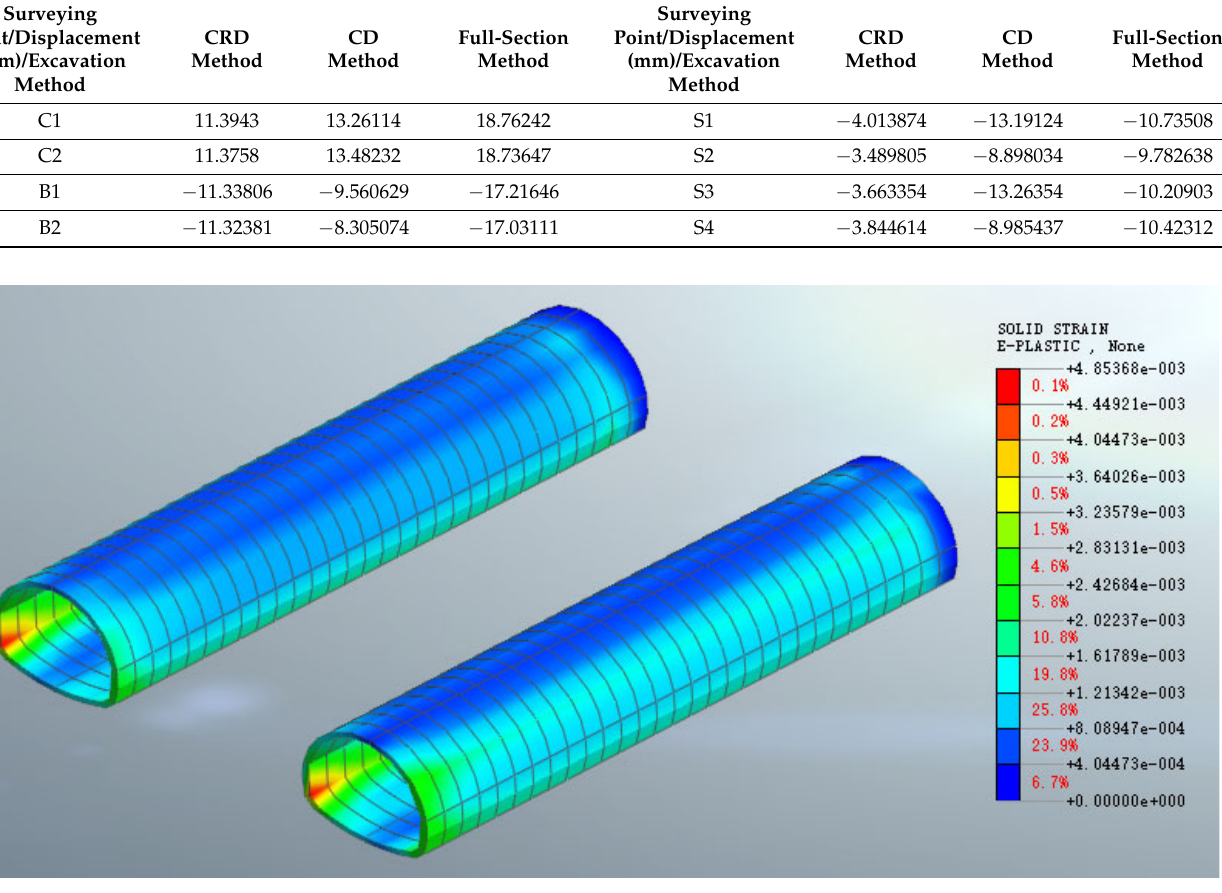
Table 5. Deformation of secondary lining with different excavation methods.